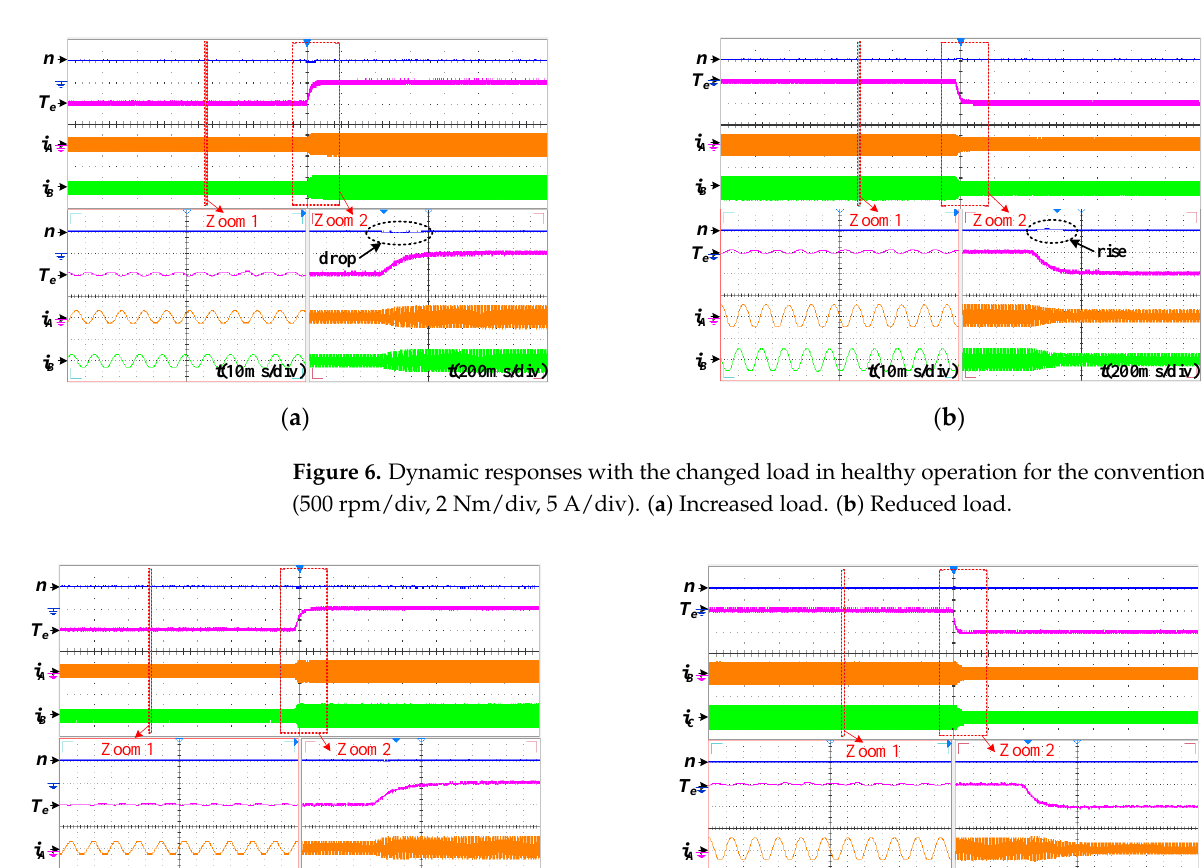
Figure 8. Experimental waveforms under normal operation, fault operation, and phase-A open-cir- cuit fault-tolerant operation. (500 rpm/div, 2 Nm/div, 5 A/div). ( a ) Traditional fault-tolerant FOC. ( b ) Proposed fault-tolerant FOC.